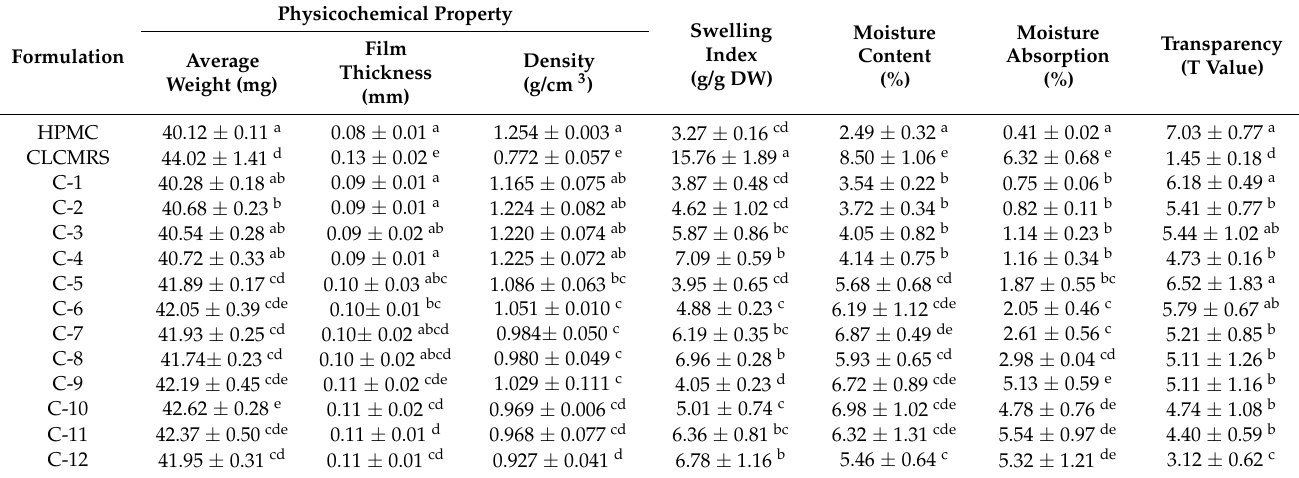
Table 3. Physicochemical properties of HPMC, CLCMRS and their composite films